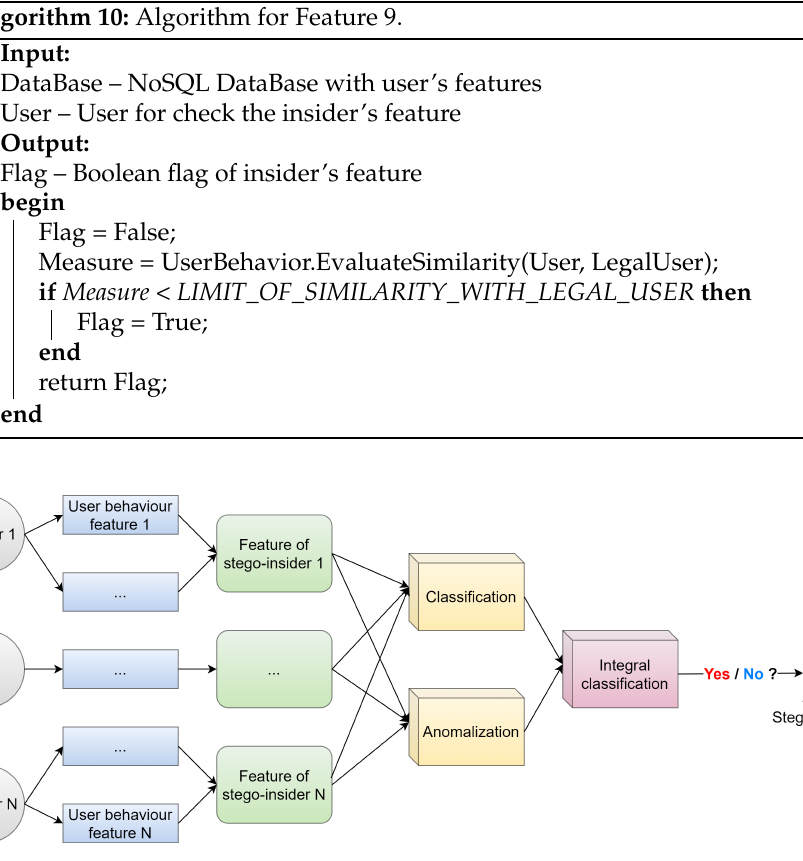
Figure 4. General scheme for determining the stego-insider. According to the scheme, scanners first collect features of user actions. Then special algorithms reveal features in them. Each feature is checked both for anomalies in it